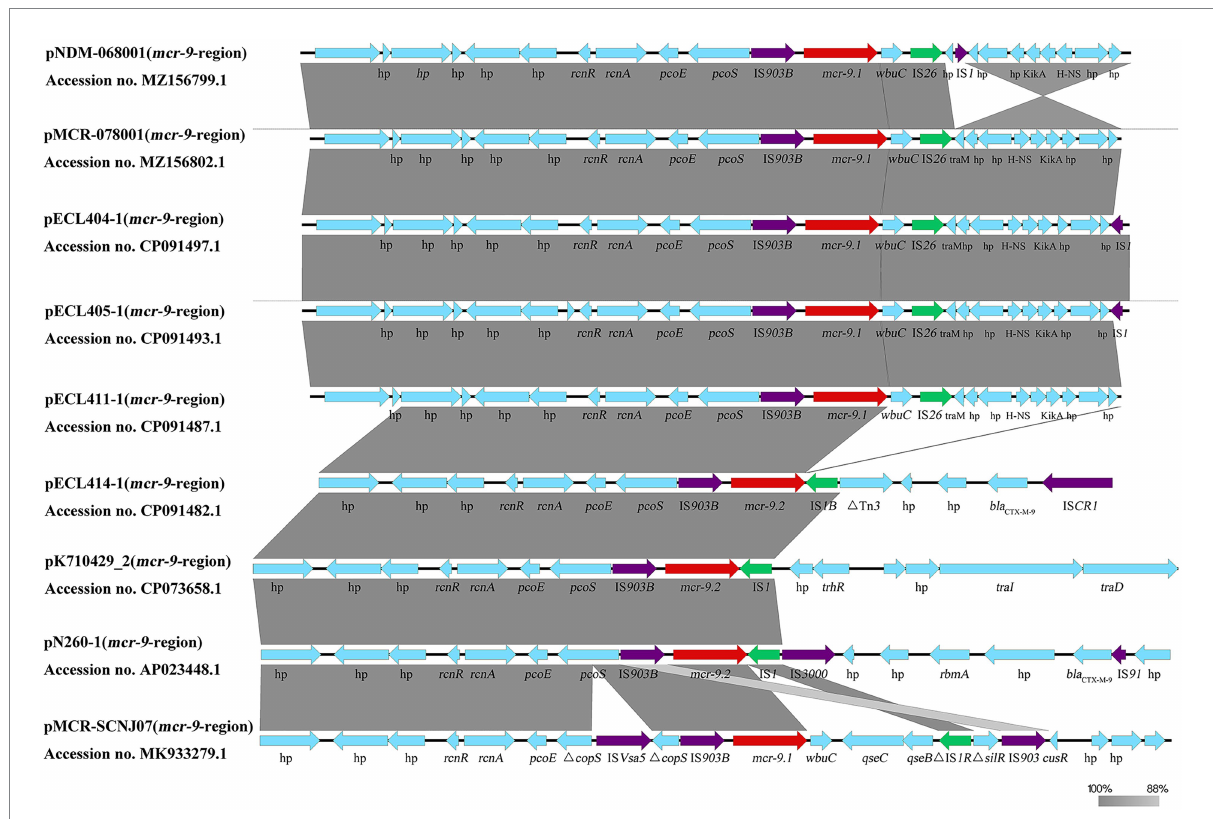
FIGURE 3 Different genetic structure surrounding the mcr-9 gene. Comparison of mcr-9 regions detected in pNDM-068001, pMCR-078001, pECL404-1, pECL405-1, pECL411-1, pECL414-1, pN260-1, pKPN7104292-2, and pMCR-SCNJ07. Gray shading denotes regions of shared homology. Arrows indicate the direction of gene